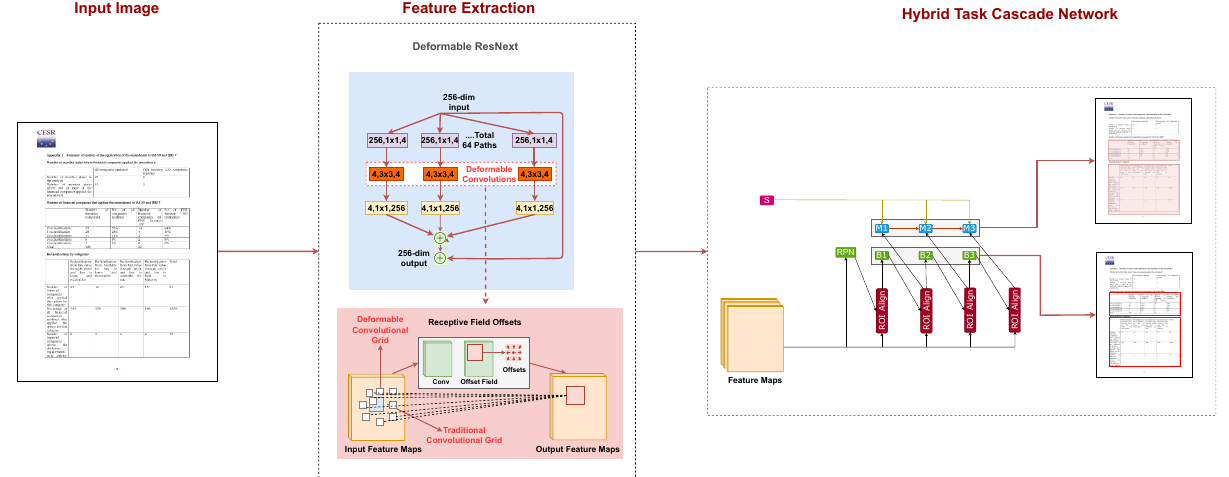
Figure 1. HybridTabNet for Table detection and segmentation. In the first step, the network performs feature extraction using ResNeXt-101 [54] with deformable convolution layers. The second step utilizes the Hybrid Task Cascade network to regress the bounding box and semantic mask coordinates of the table in the